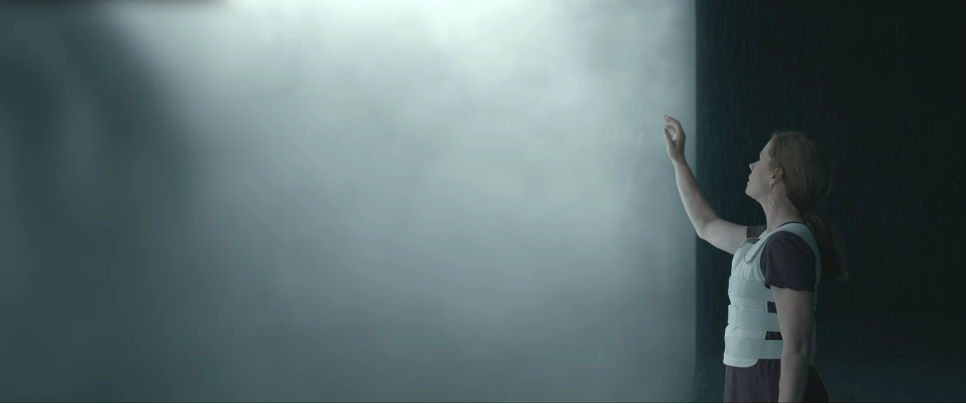
Figure 2: Arrival . Louise and the transparent glass